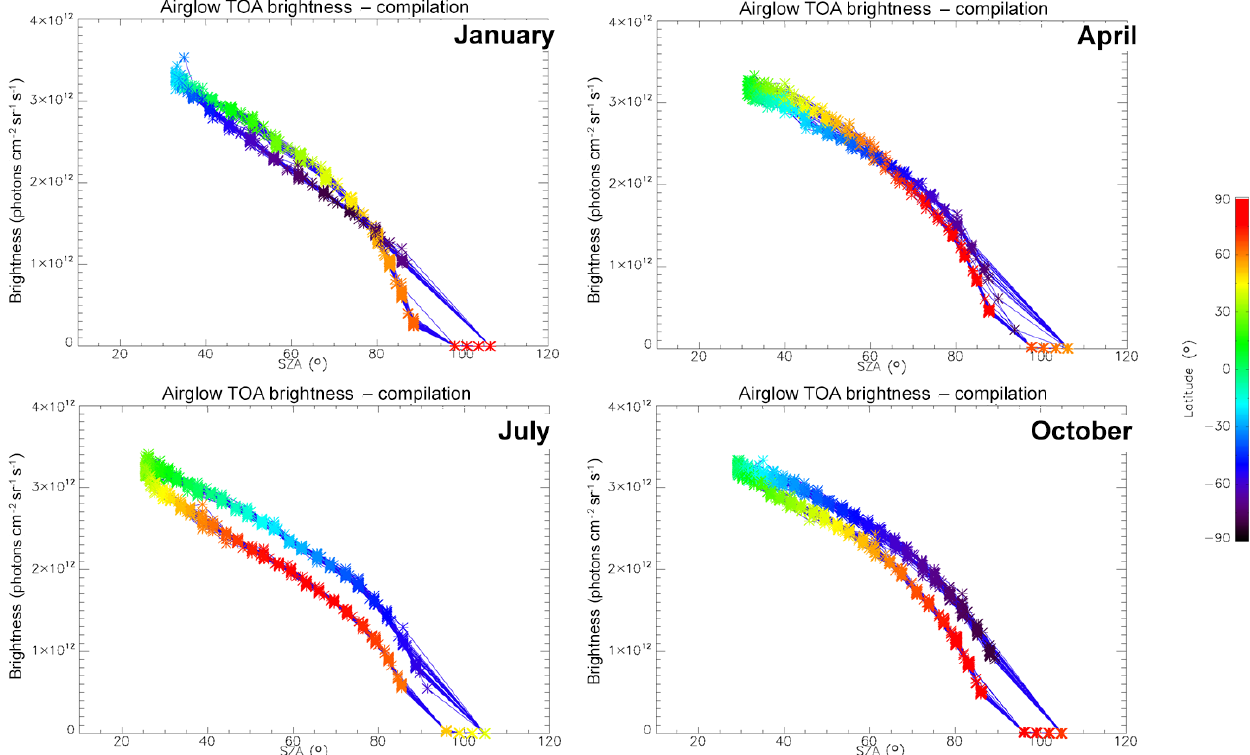
Figure 8. O 2 ∗ airglow intensities that would be seen at nadir as a function of SZA for the months of January, April, July, and October 2007 (first 3d of each month only), retrieved from the processing of SCIAMACHY limb data. The colour scale represents the latitude. There is a geometrical correlation between the latitude and SZA imposed by the polar orbit of Envisat. The airglow brightness is mostly correlated with SZA. The comparison of these intensities with those obtained by the REPROBUS airglow model is presented in Sect.